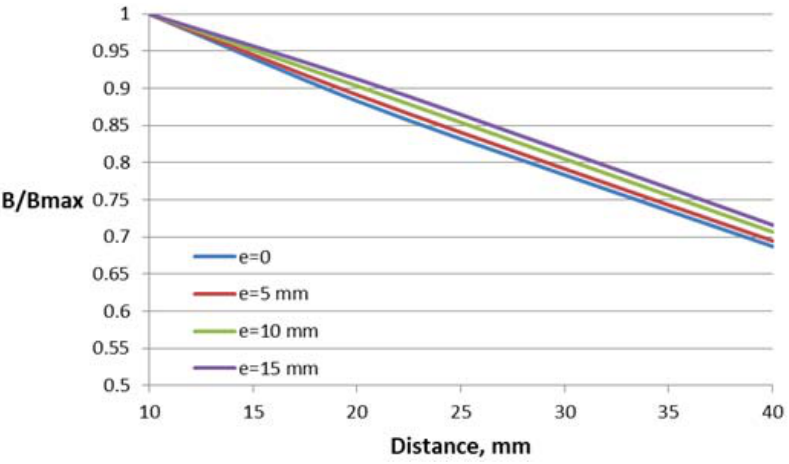
Figure 9. Dependence of the flux density on the distance to the conductor for the concentrator with one gap and different conductor deflections in the transversal direction e .